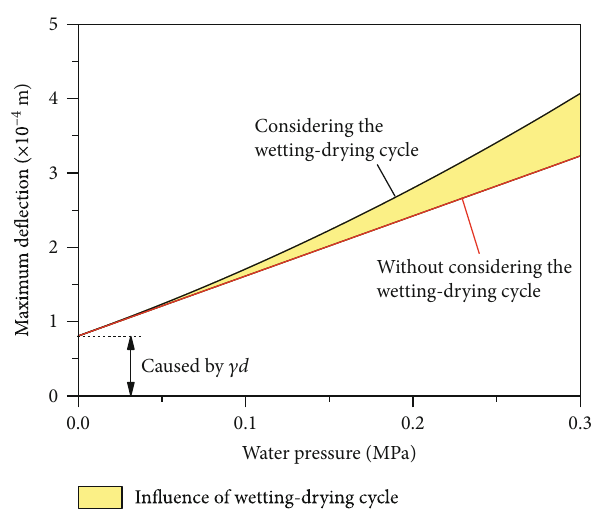
Figure 10: Relationship between the maximum de fl ection and water pressure.